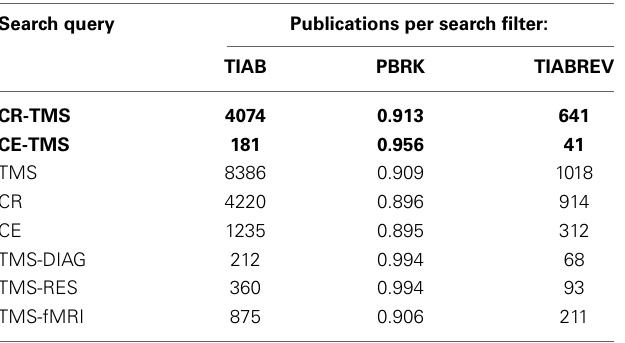
Table 2 | Number of publications retrieved from PubMed using search queries defined previously.